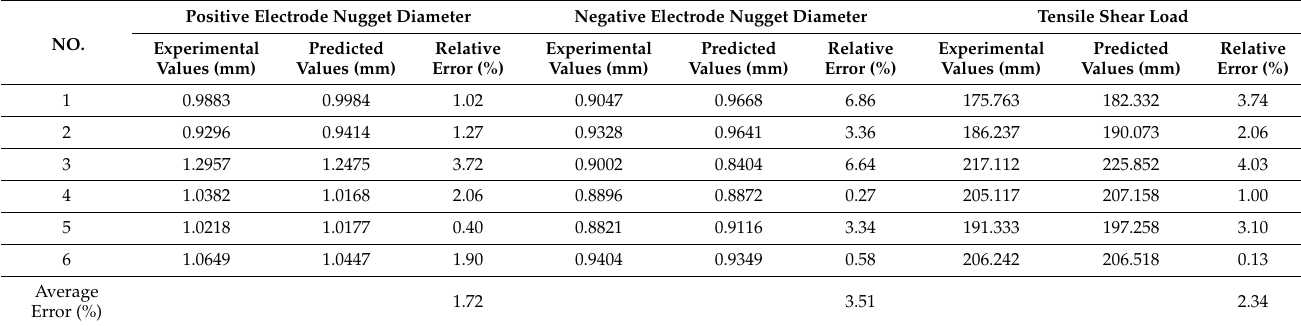
Table 5. The accuracy of the established CGO–MLSSVR